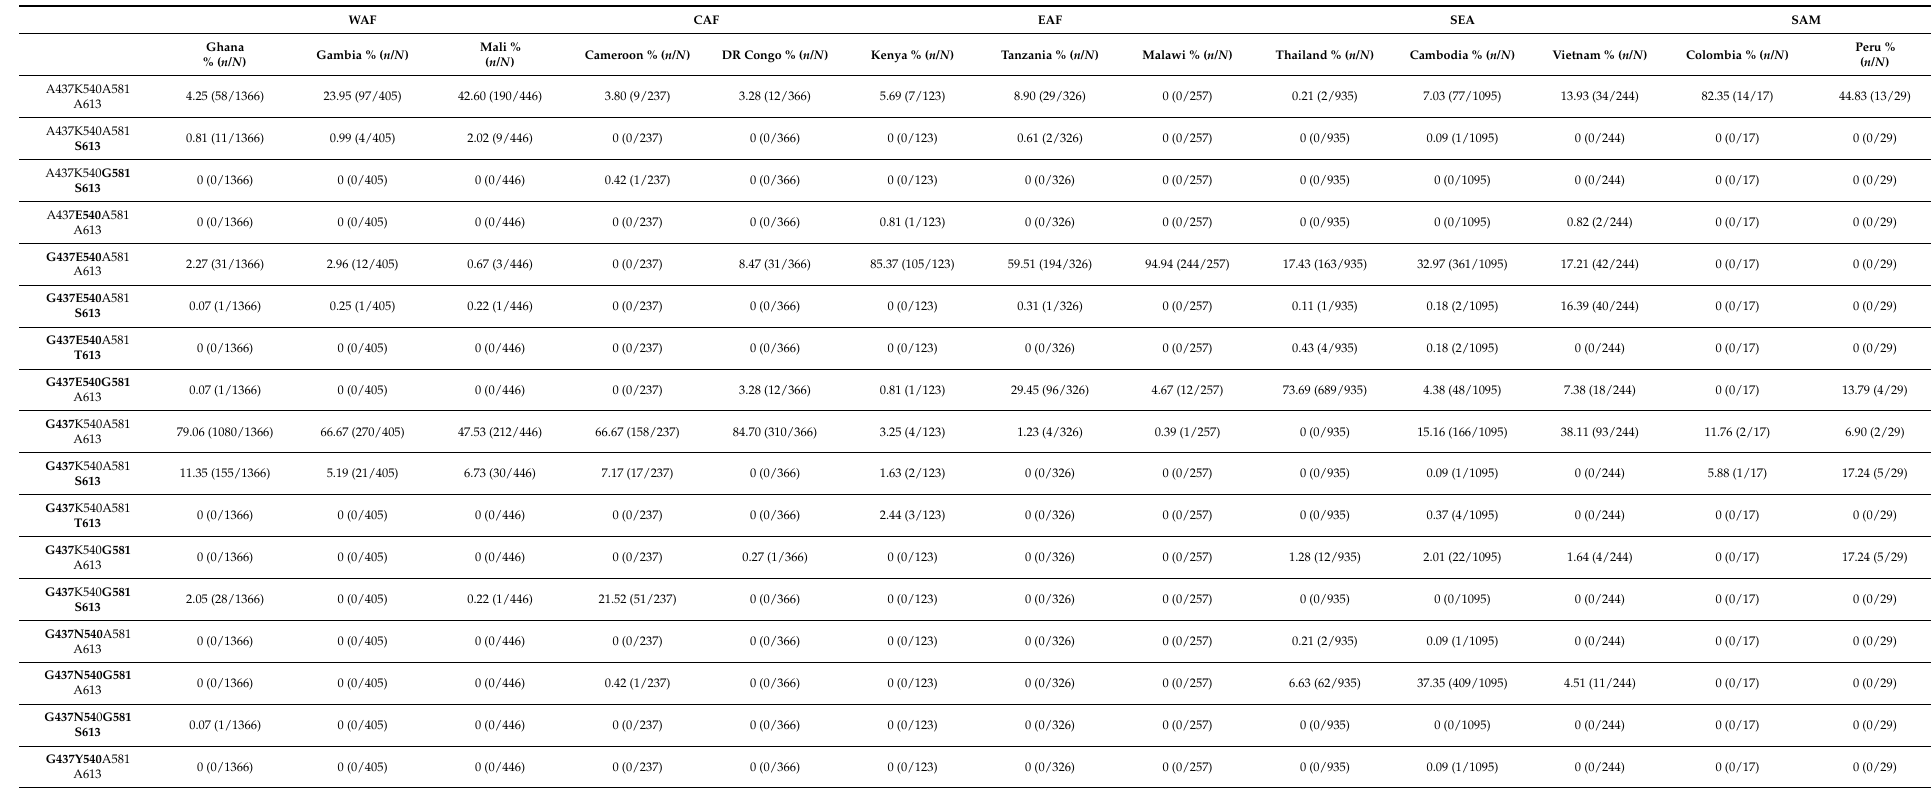
Table 2. Global frequency of key Pf dhps haplotypes. Amino acid changes are highlighted in